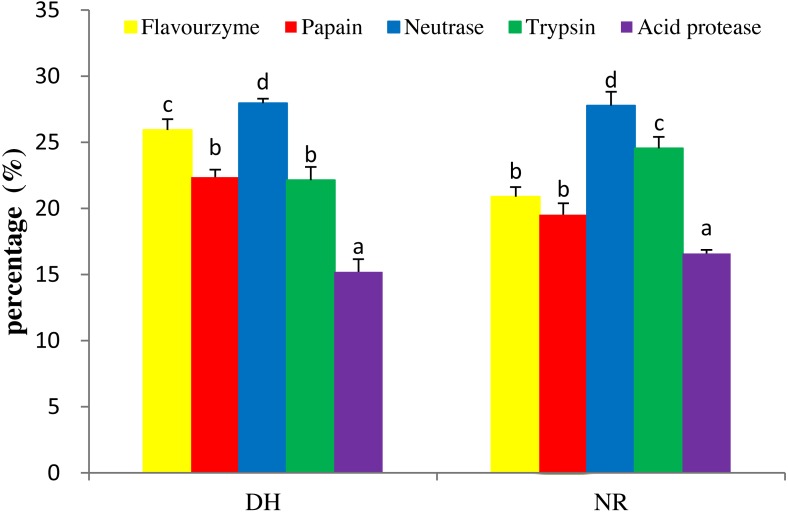
DH and NR of mackerel viscera produced by various proteases.DH, degree of hydrolysis; NR, nitrogen recovery; Data were presented as means ± SD. Different letter indicated significant differences between groups (P < 0.05) according to variance analysis (ANOVA) using the SPSS software and means were compared by Duncan’s multiple comparison post-test.